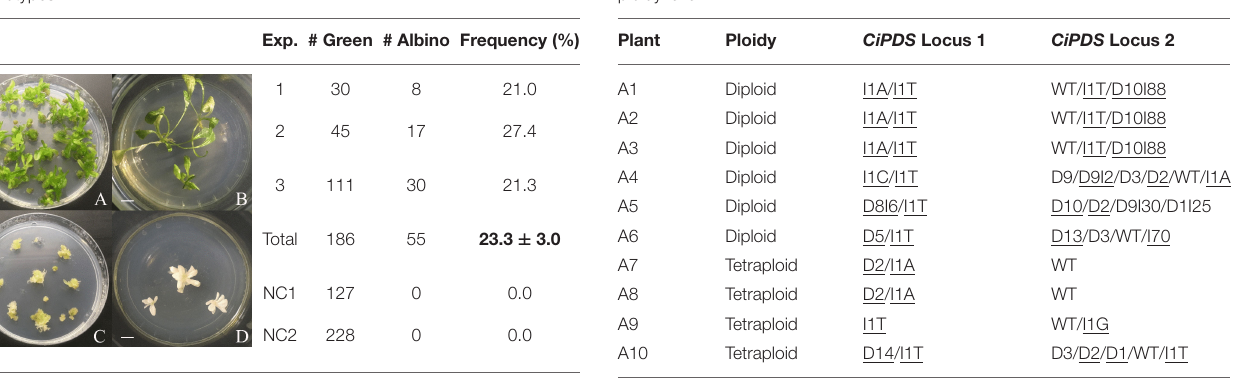
TABLE 2 | Regeneration of witloof protoplasts and frequency of albino phenotypes.